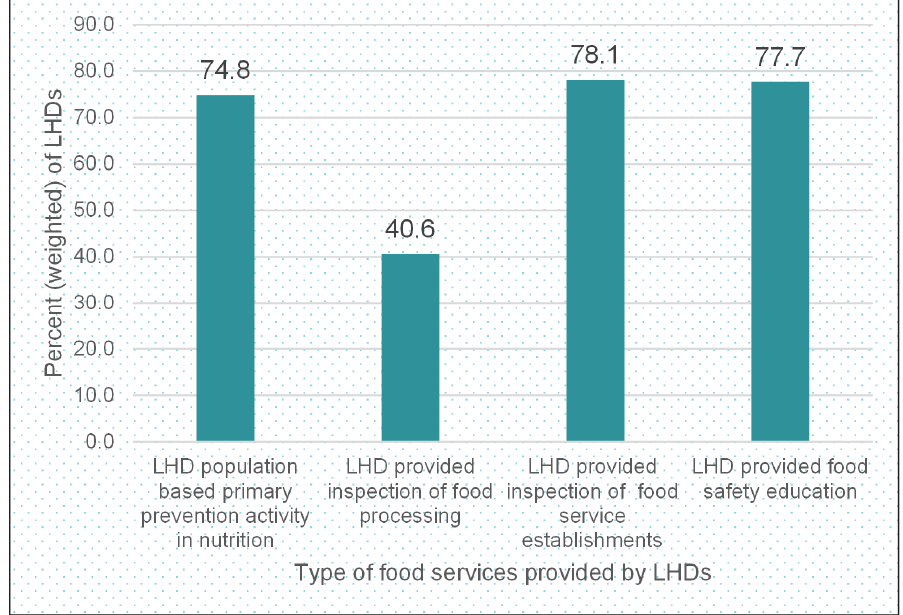
Figure 1. Percent of LHDs by type of food safety and other related services provided directly by local health departments. 2019 Profile of LHDs.